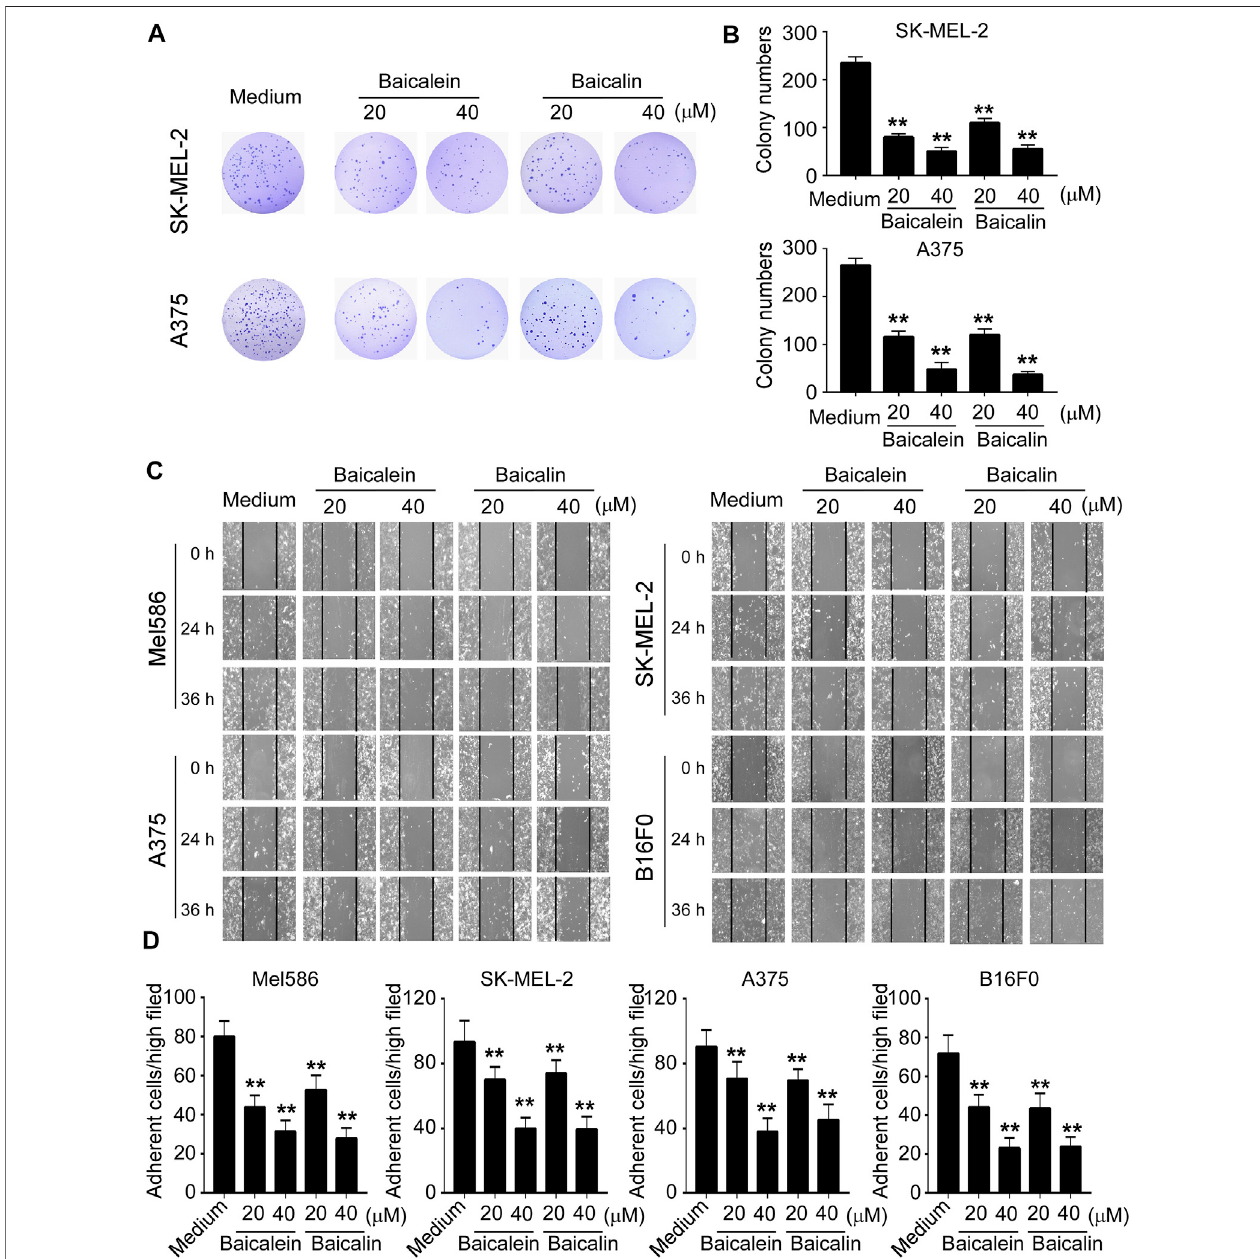
FIGURE 2 | Baicalein and baicalin inhibit melanoma cell colony formation, migration and adhesion. (A,B) Baicalein and baicalin treatments dramatically decreased the numbers and sizes of tumor colonies in SK-MEL-2 and A375 cells. 200 – 500 per well of melanoma cells pre-treated with the indicated concentrations of baicalein or baicalin,wereseededin6-wellplates forculture,and cellcoloniescounted after 10 – 14 daysofculture.Resultsshown inthehistogram (B) aresummariesofmean±SD from threeindependent experiments. ** p < 0.01comparedwiththemedium controlgroup. (C) Differentconcentrationsofbaicaleinandbaicalin treatments inboth human and mouse melanoma cells signi fi cantly inhibited tumor cell migration compared with the medium control group at 24 and 36 h time points in the wound closure assays. Data shown are representatives from three independent experiments with similar results. (D) Baicalein and baicalin treatments suppressed the adhesion of melanoma cells. Both human and mouse melanoma cells pretreated with the indicated concentrations of baicalein and baicalin were cultured in the fi bronectin-coated plates for 45 min. Adherent cells were counted and averaged in 10 fi elds at high (×400) magni fi cation with a microscope. Results shown are summaries of mean ± SD from three independent experiments with similar results ** p < 0.01 compared with the medium control group.